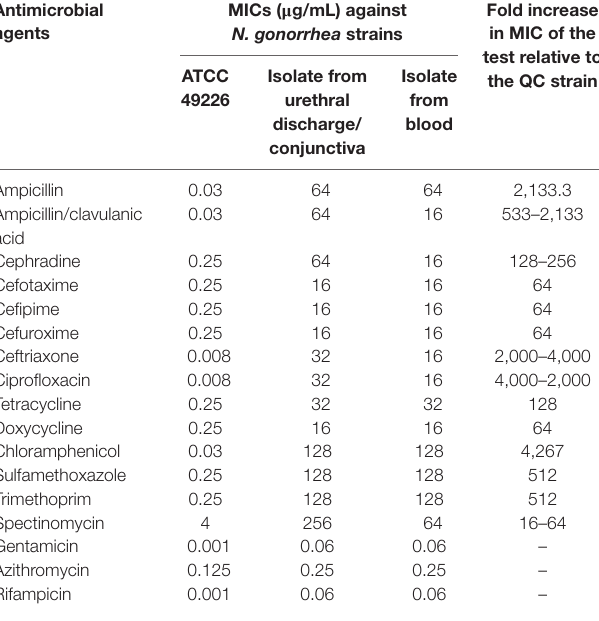
taBle 1 | The minimum inhibitory concentrations (MICs) of different antimicrobials tested against N. gonorrhoeae strains. antimicrobial agents